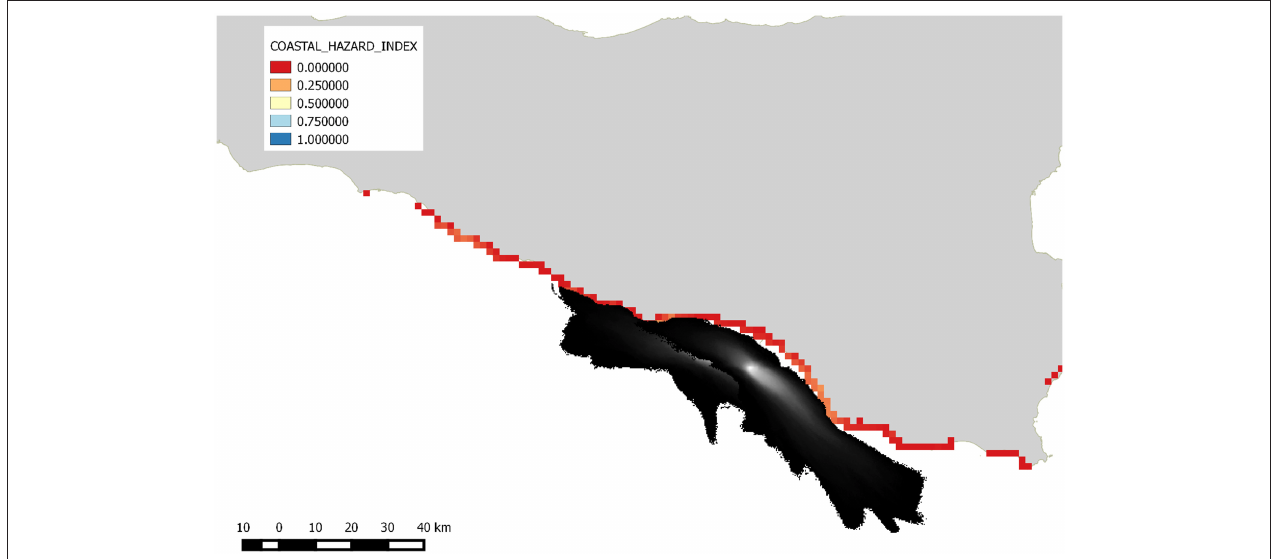
FIGURE 6 | Coastal Hazard Index for the Sicily platforms. In order to compare the extension of the hazard distribution, the shape of the marine OI is also represented in black-to-white. CHI is dimensionless and in the range 0 −